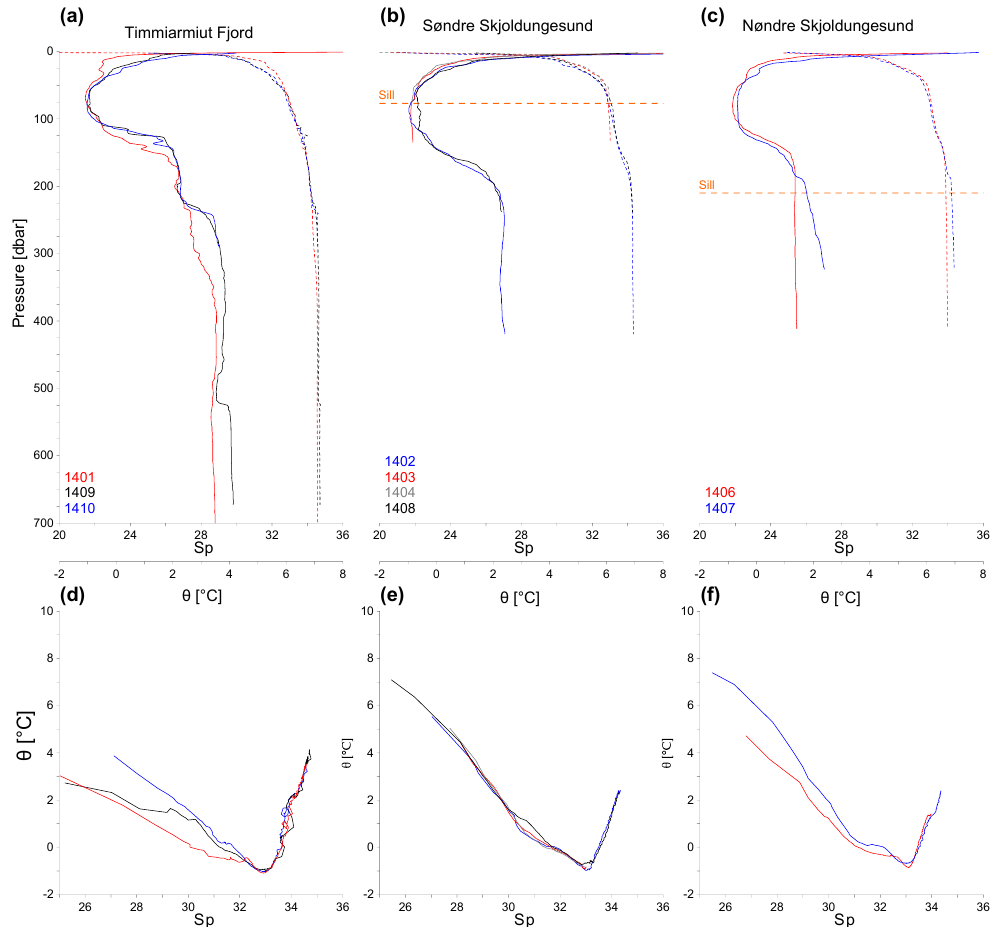
Figure 6. Temperature and salinity profiles and the corresponding T – S diagrams for Timmiarmiut Fjord (a, d) , Søndre Skjoldungesund (b, e) , and Nørre Skjoldungesund (c, f) . Approximate sills depths retrieved from the bathymetry data are illustrated in (b, c) .